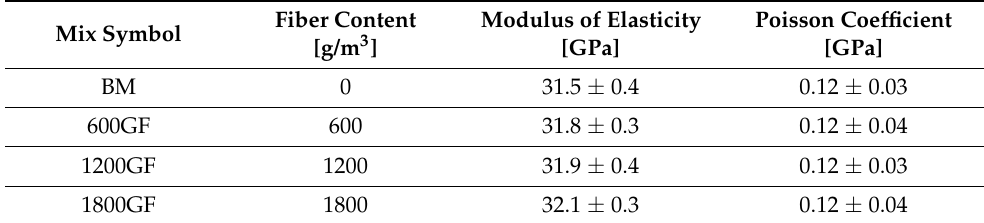
Table 8. Modulus of elasticity and Poisson